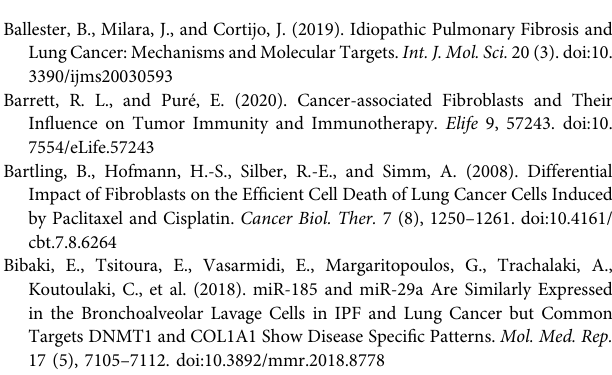
standardizationofGSE24206; (B) :Backgroundcorrectionanddatastandardization ofGSE53845; (C) :BackgroundcorrectionanddatastandardizationofGSE101286; (D) : Background correction and data standardization of GSE110147. Supplementary Figure S2 | The correlation between cancer-associated fi broblast and COL1A1, COL3A1, POSTN, TIMP3. Notes: (A-D) : The correlation between cancer-associated fi broblast and COL1A1, COL3A1, POSTN, TIMP3 in TCGA- LUAD cohort; E-H: The correlation between cancer-associated fi broblast and COL1A1, COL3A1, POSTN, TIMP3 in TCGA-LUSC